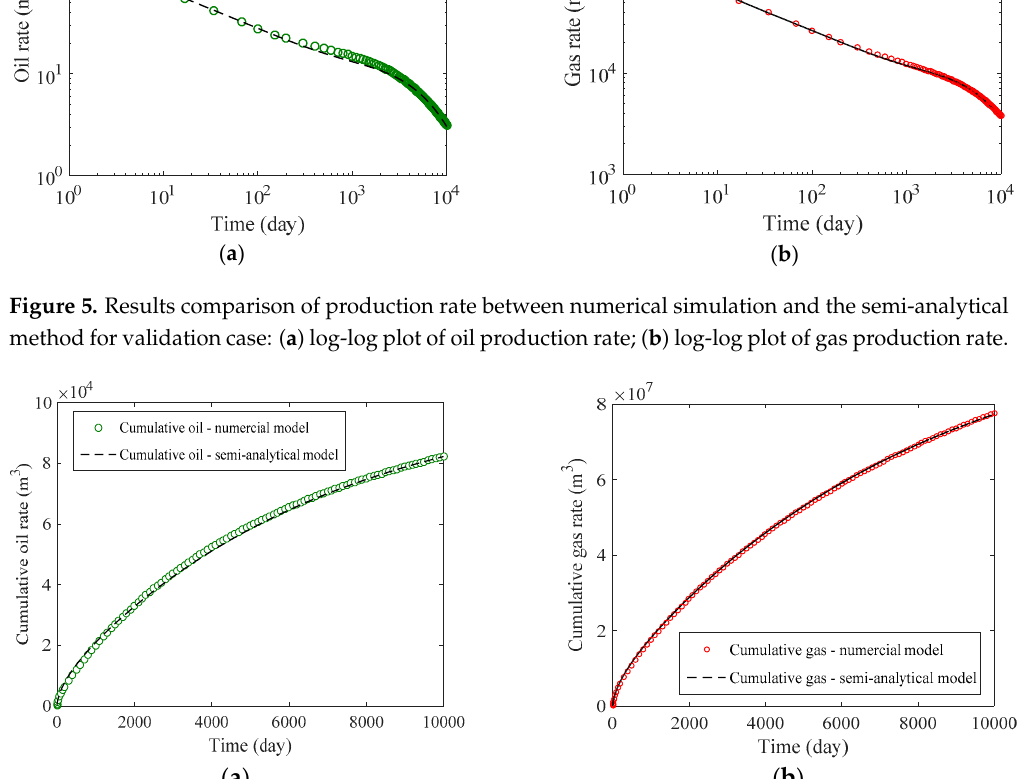
Table 2. Basic parameters used for the sensitivity analysis.